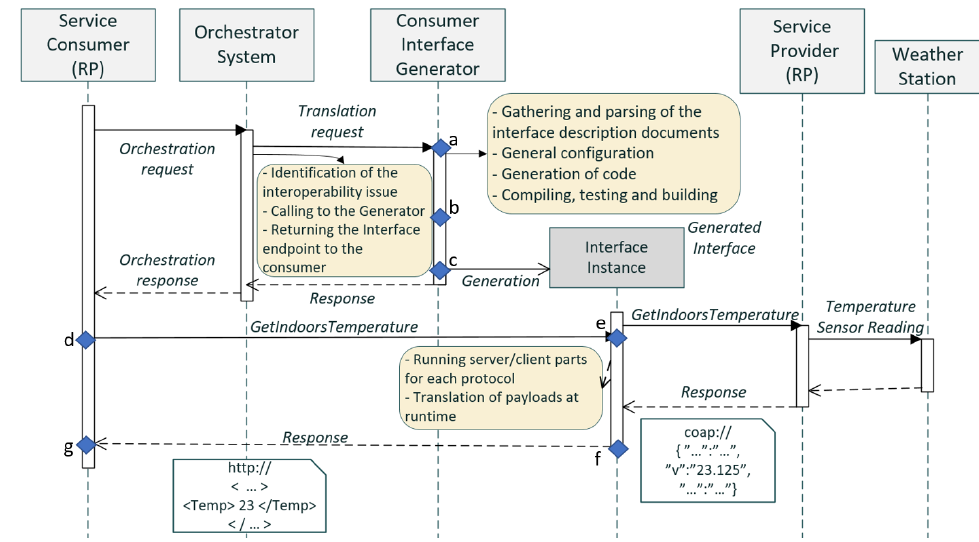
Figure 7. UML Sequence diagram for service consumption using the consumer interface generator.